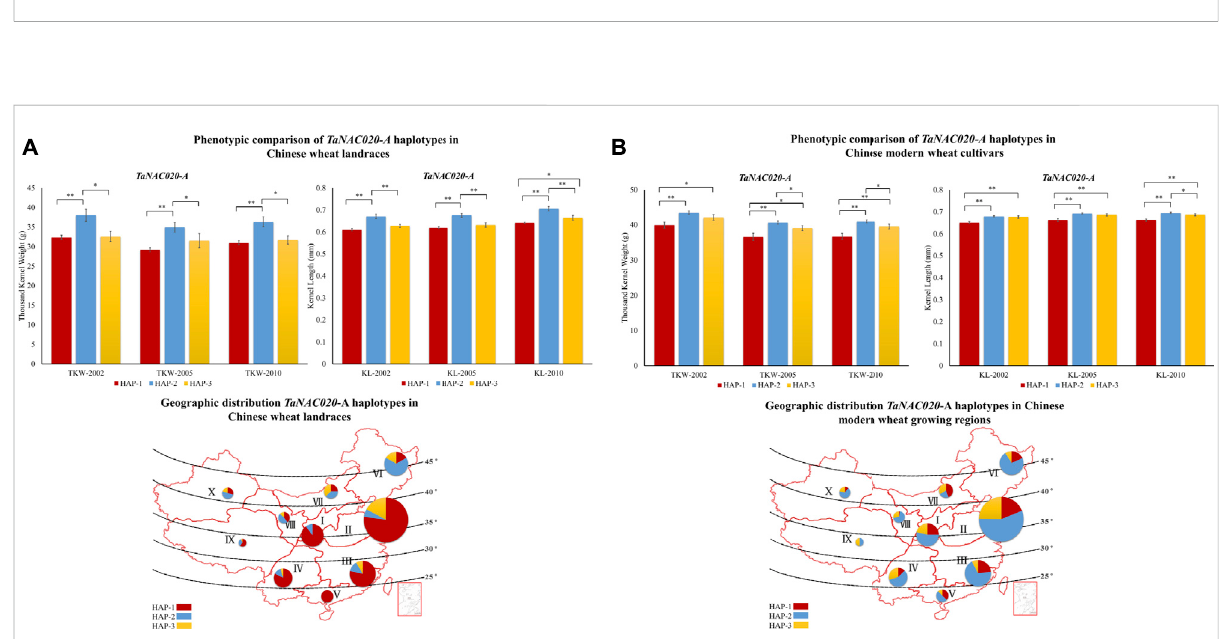
FIGURE 3 Molecular marker development for TaNAC020-A/B/D. (A) Gene structure, SNP sites, and KASP markers for TaNAC020-A . (B) Gene structure, SNP sites, and KASP marker for TaNAC020-B . (C) Gene structure of TaNAC020-D . Red = upstream of ATG, yellow = exon, black line = intron, and blue = downstream of TGA. Scatter plot for KASP assays showing clustering of accession on X-(HEX) and Y-(FAM) axes, and the black square represents non-template control.